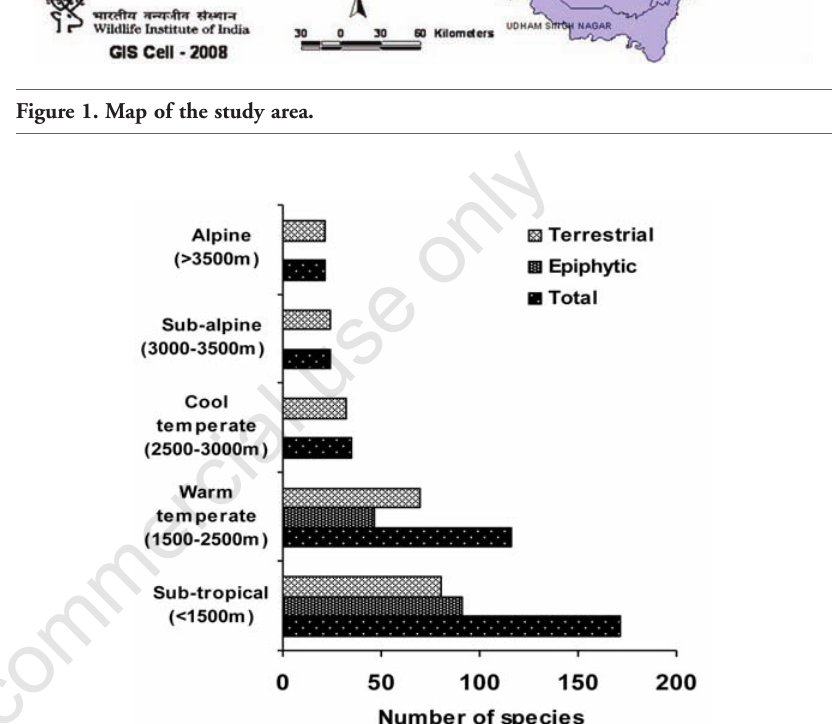
Figure 2. Distribution of orchids in the various eco-climatic zones.